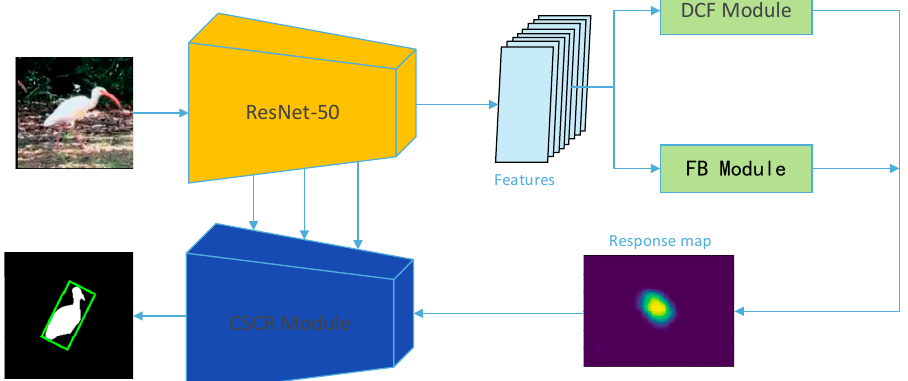
Figure 5. The refined segmentation-based tracker (RPVT) architecture. The backbone features extracted from Resnet-50 are used to obtain the approximate target location and the foreground and background information by DCF module and FB module, respectively. Finally, the response map is obtained by fusing the target location and the foreground and background information, and finally, the mask is gradually optimized by combining the backbone features.